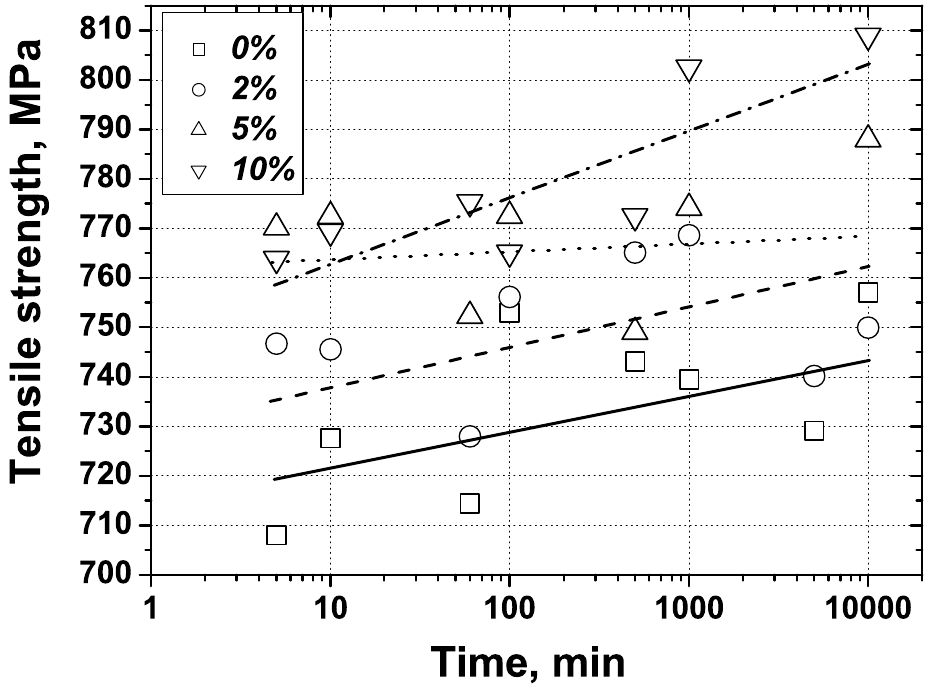
Figure 10. Tensile strength after aging as function of the aging time for aging at 170 ◦ C from 5 to 10,000 min for 0%, 2%, 5%, and 5% prestrain for the TRIP3